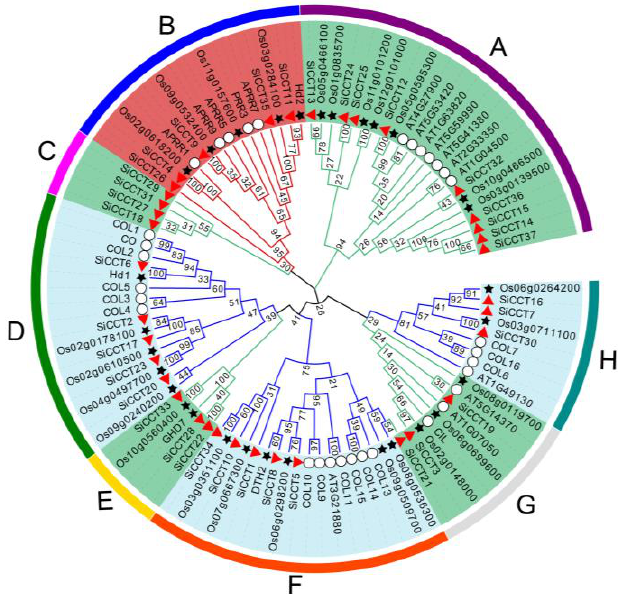
Figure 2. Phylogenetic relationships of CCT proteins. The phylogenetic tree was constructed from 100 protein sequences from millet, rice, and Arabidopsis using the maximum likelihood method with 1000 bootstrap replicates. The lines of different colors indicate different groups. Three subfamilies of CCT proteins are represented by different colored lines. Hollow circles, black stars, and red triangles represent the CCT proteins of Arabidopsis, rice, and millet,